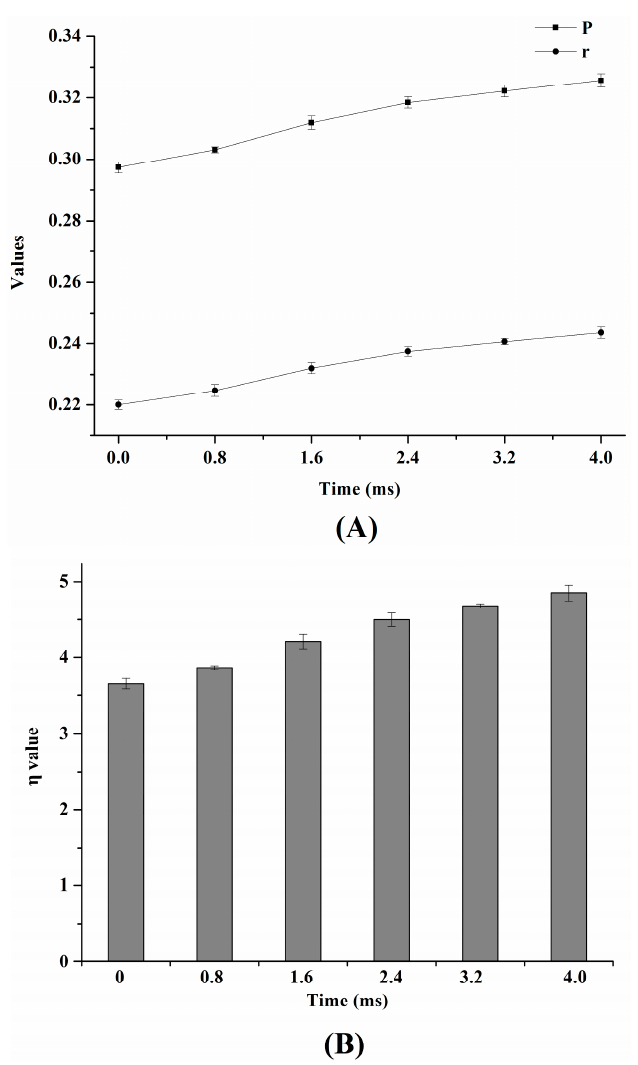
Figure 2. The alterations of ( A ) fluorescence polarization ( P ), fluorescence anisotropy ( r ); and ( B ) micro-viscosity ( η ) of cytoplasmic membrane of S. typhimurium after PEF treatments at 25 kV/cm for 0–4 ms.